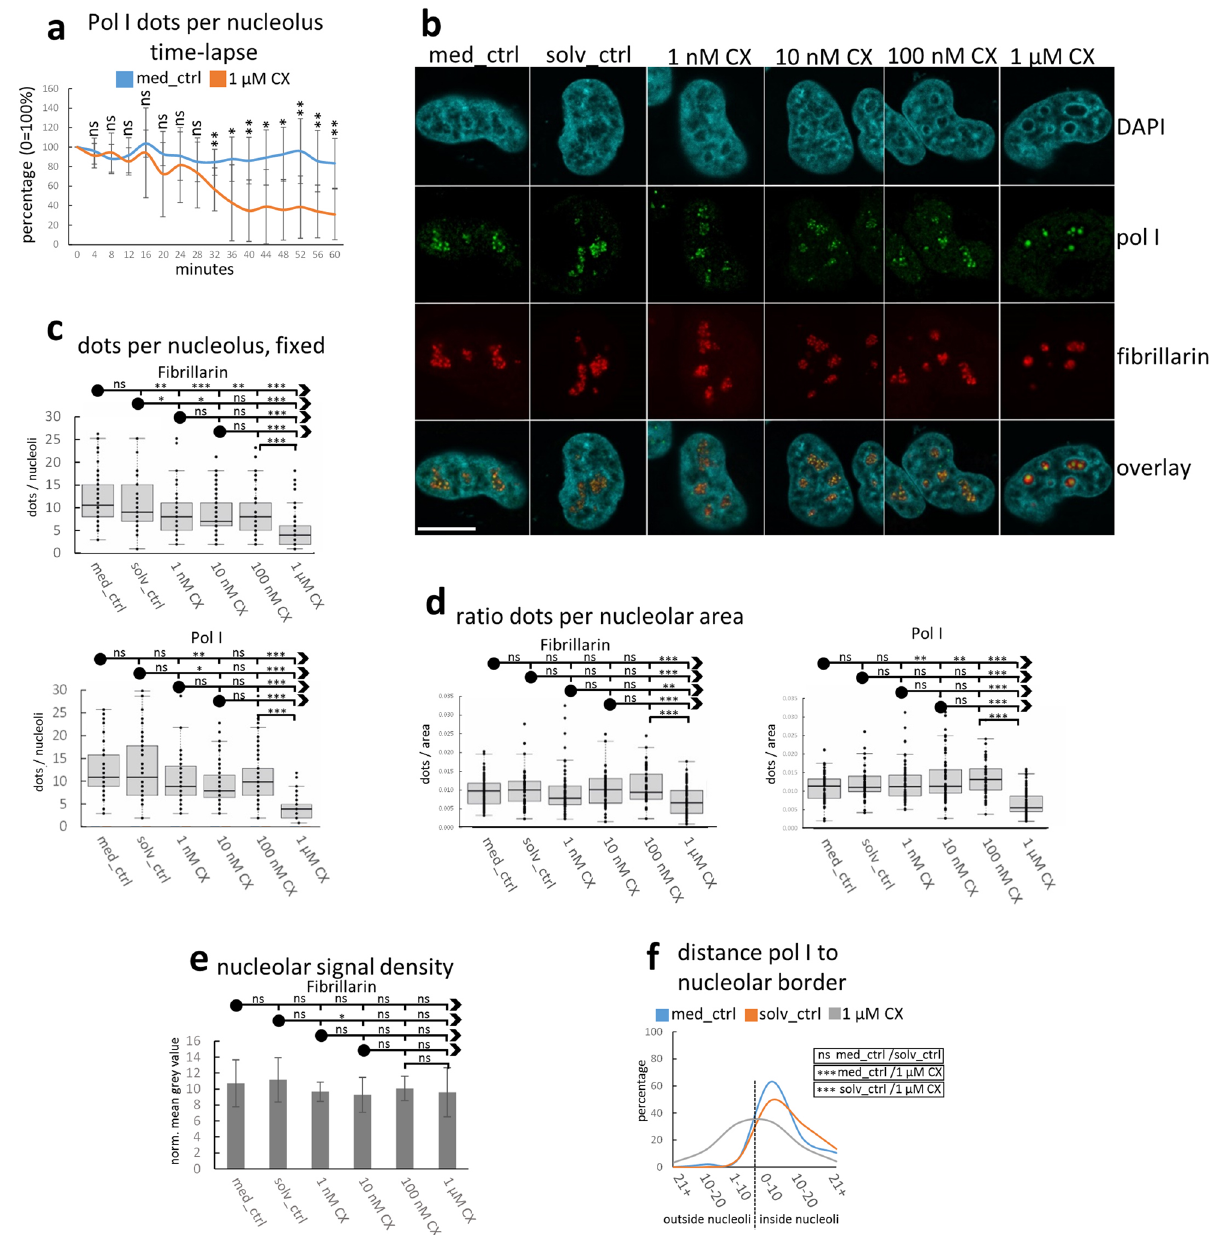
Figure 3. Morphological changes of localization of prominent markers for nucleolar functions upon CX-5461 treatment; HeLa cells. ( a ) Time-lapse imaging over 1 h demonstrates drastic reduction of the number of pol I dots per nucleolus in HeLa cells expressing H2B-mCherry and pol I-GFP upon CX-5461 incubation (each 6 cells out of 1 experiment); ( b ) in fixed cells, both fibrillarin and pol I show abundant foci per nucleolus in control cells and few bright spots in 1 µM CX-5461- treated cells (representative cells; single confocal sections); ( c ) graphs show the decline in foci numbers per nucleolus in fixed cells with increasing concentration of CX-5461; (a mean of 16 nucleoli per category was evaluated in 3 independent experiments); ( d ) graphs indicate the relation of dot number to nucleolar area in fixed cells declining at 1 µM CX-5461; (a mean of 16 nucleoli per category was evaluated in 3 independent experiments) ( e ) the mean fibrillarin intensity per nucleolus does not change significantly at 1 µM CX-5461 in fixed cells (a mean of 16 nucleoli per category was evaluated in 1 experiment); ( f ) graph demonstrating shift of pol I-foci towards nucleolar periphery after incubation with 1 µM CX-5461 as evaluated in fixed cells; dashed line indicates nucleolar border; pixel categories given on x-axis (e.g. 0 to 10 pixels inside the nucleolar border) and percentage of total per sample at the ordinate; statistical evaluation represents summed dots located inside and outside nucleolar border (a mean of 169 pol I signal dots per category was evaluated in 3 independent experiments). Bar and line graphs display means, error bars represent standard deviations; box plot charts show first and third quartile, sample median and whiskers (1.5× interquartile range); Student’s t -test was applied except in ( f ) (Chi-square test). Bar = 10 µm; ns not significant, *P < 0.05, **P < 0.01, ***P <